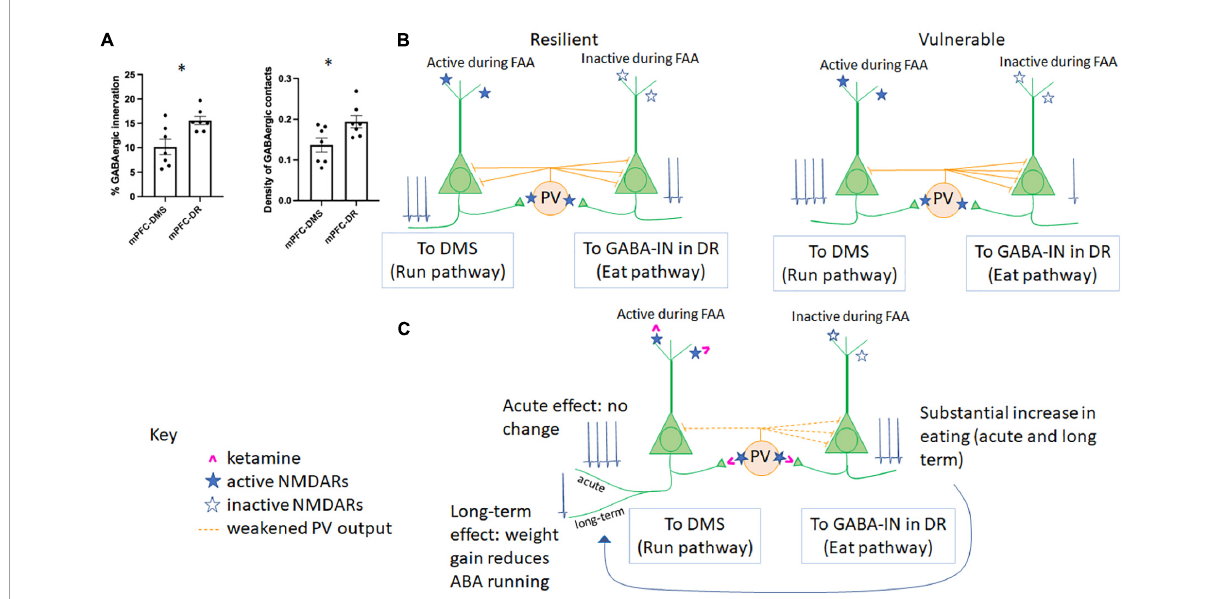
FIGURE2 Microcircuitry of the mPFC determines resilience vs. vulnerability to ABA and responsiveness to ketamine. (A) GABAergic innervation in the mPFC differs across populations of Layer 5 pyramidal neurons. The percent of somatic pyramidal cell membrane contacted by GABAergic terminals (left) and the density of GABAergic terminals contacting somatic pyramidal cell membrane (right) have been previously reported for pyramidal cells in Layer 5 forming mPFC-DMS (Santiago et al., 2021) and mPFC-DR (Du et al., 2022) subpopulations. Here, we report significantly less GABAergic innervation of the pyramidal cells forming the mPFC → DMS pathway vs. those forming the mPFC → DR pathway ( p = 0.0104, t = 3.031, df = 12 comparing the % membrane innervation; p = 0.0271, t = 2.515, df = 12, comparing GABA contact density). (B) The relationship between GABAergic innervation and individual differences in ABA vulnerability. In the same two publications as those summarized in panel (A) , we reported that greater GABAergic innervation of pyramidal cells forming the mPFC → DMS pathway correlates with suppression of running (resilience) while greater GABAergic innervation of pyramidal cells forming the mPFC → DR pathway correlates with reduced feeding (vulnerability). (C) Hypothesized mechanism of action of ketamine in the mPFC of animals undergoing ABA. During FAA, pyramidal cells forming the mPFC → DMS pathway are active to produce hyperactive running, while pyramidal neurons forming the mPFC → DR pathway are less active as there is no ability to feed during this time. PV cells are more likely to be active in awake, hyperactively running mice than those mice with suppressed wheel running. Because ketamine (pink) binds to active NMDARs (filled blue star) rather than inactive NMDARs (open blue star), we would expect ketamine that is injected during FAA, 1 h prior to feeding, to weaken firing of PV cells, yielding disinhibition and of the pyramidal neurons of the mPFC → DMS pathway, specifically. Because PV cells are more likely to target mPFC-DR cells vs. mPFC-DMS cells [as shown in panel (A) ], we would expect the acute response to ketamine to be an increase in mPFC → DR cell firing, resulting in increased feeding, with no net acute effect on pyramidal cells of the mPFC → DMS pathway, resulting in no net acute change in running behavior, which is what we observe during ABA1. Ketamine is known to have sustained effects on behavior. We observed that the increase in feeding is sustained to ABA2, and we also observe reduced running by ABA2, > 14 days later (Chen et al., 2018b). This parallels findings in patients with anorexia nervosa, which is that increased feeding helps to reduce disorganized hyperactivity (Crisp, 1967; Kron et al.,